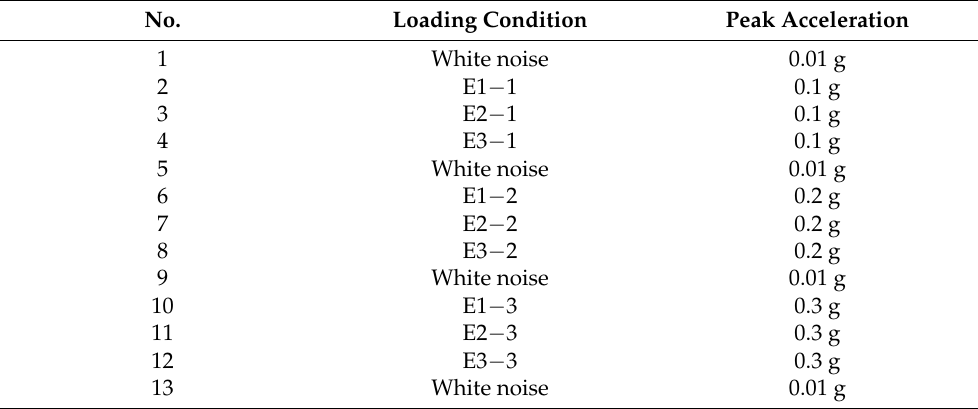
Table 4. Excitation sequence of input ground motions.